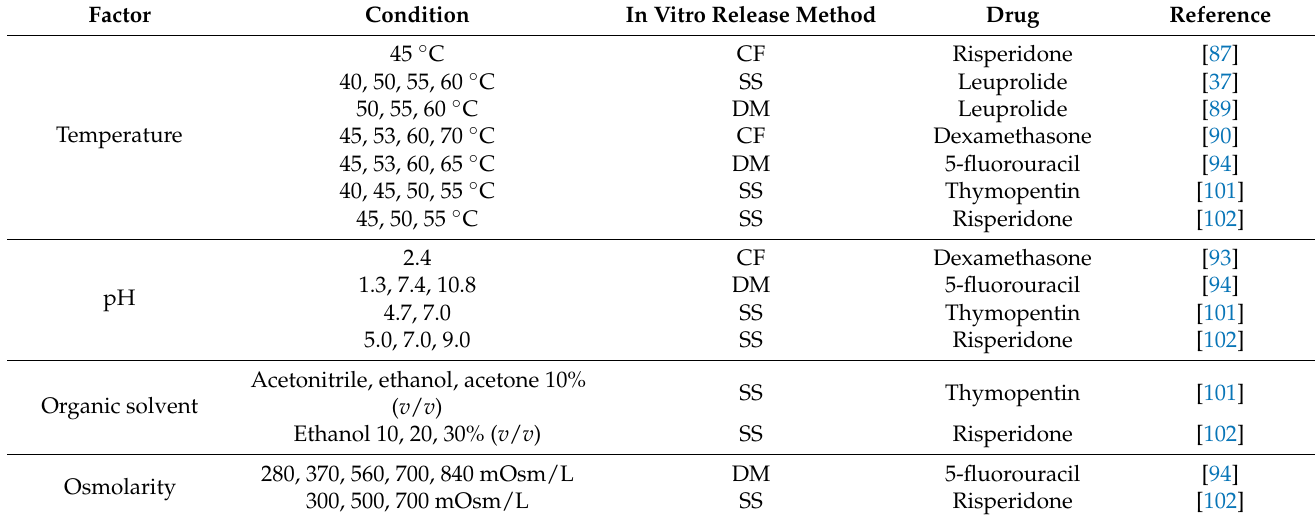
Table 3. Summary of factors and in vitro release methods studied for accelerated in vitro release testing of polymeric microparticle